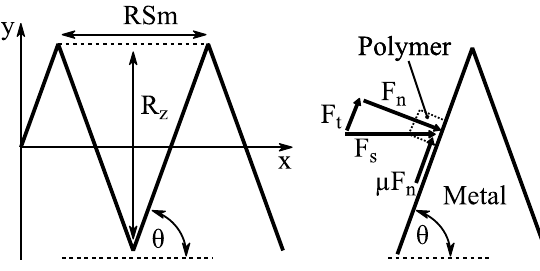
Figure 5. Roughness slope and resulting forces.